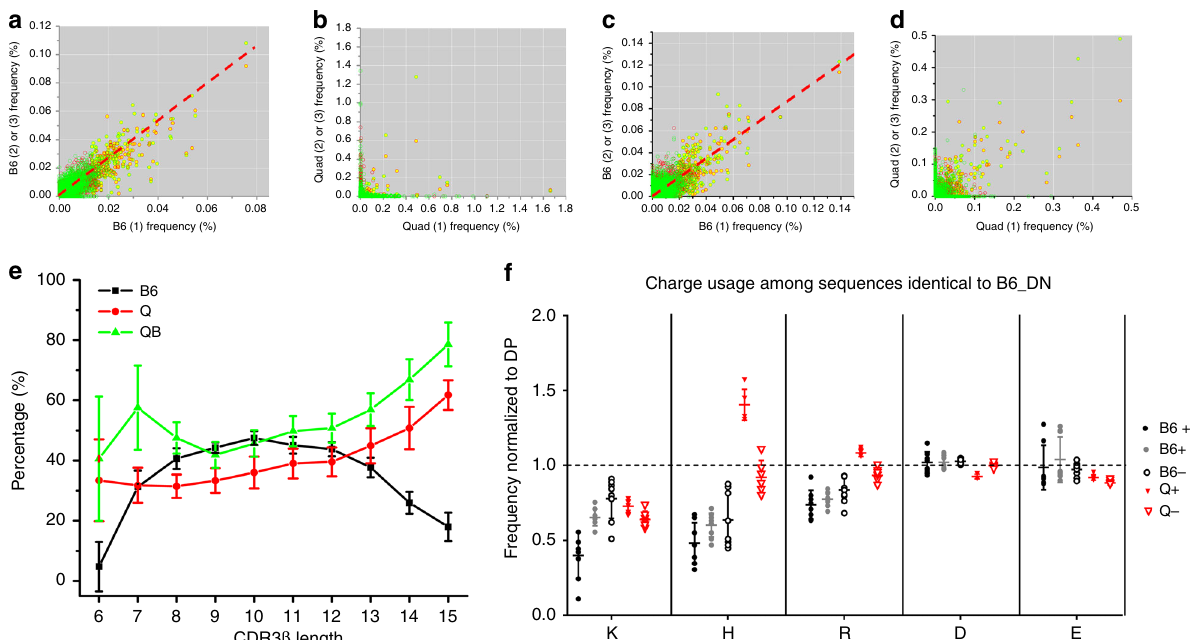
Fig. 8 Frequency scatter plots. a , c Frequency scatter plots among MHC-restricted TCR β ( a ) and TCR α ( c ) repertoires from individual B6 mice. b , d Frequency scatter plots among MHCi TCR β ( b ) and TCR α ( d ) repertoires from individual Quad ko sequences. Each panel contains the comparison of three independent sequence repertoires from each strain of mice with the horizontal axis representing the frequencies of the fi rst repertoire sequences, vertical axis representing the frequencies of the second (red circle) and third (green circle) repertoires. Common sequences between repertoire 1 and 2 are shown as red circles in the fi rst quadrant with horizontal and vertical coordinates representing their respective frequencies in repertoire 1 and 2. Common sequences between repertoire 1 and 3 are shown as green circles with horizontal and vertical coordinates representing their respective frequencies in repertoire 1 and 3. Non-overlapping sequences appear on their respective axes. Top 200 common sequences present in all three repertoires are shown as fi lled yellow circles. Linear regressions of the frequency distributions between B6 repertoires 1 and 2 are shown in red lines. e CDR3 β length-dependent expansion of MHCr and MHCi sequences from pre-selection repertoires. The percentage of expanded TCR β sequences during thymic selection were plotted according to their CDR3 length for B6, Quad ko and Quad ko Bcl-2 tg . The analysis included common sequences between pre-selection (B6_DN) and MHCr (B6) or MHCi (Q and QB mice) repertoires. Expansion is de fi ned as sequences whose mature frequencies (normalized for all comparing repertoires) were higher than their pre-selection ones. f Charged amino acid usages of CDR3 β FG-loop in common sequences between pre-selection and MHCr or MHCi repertoires. B6 ( + 5%), top 5% TCR β sequences of B6 repertoires; B6 + , B6 − , Q + , and Q − represent mature sequences either expanded ( + ) or